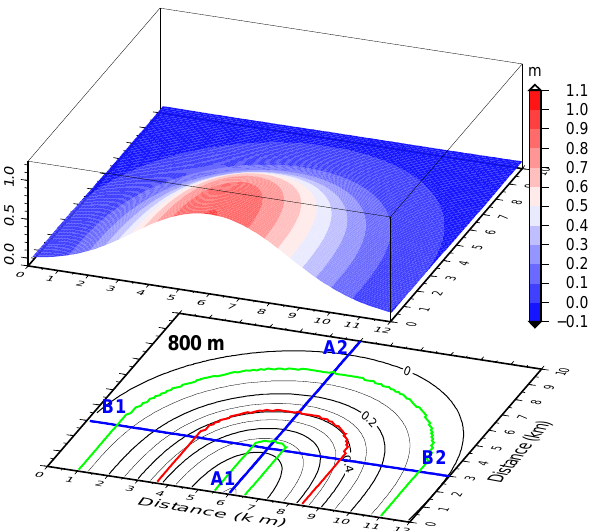
Figure 16. Elastic bulging of an 800m thick ice slab (upper part) in response to a 1m bottom water push exerted over the domain as outlined in red (bottom part). Green contours show the two extreme fjord geometries of the sensitivity test (see Fig. 18) whereas the black ones are the deformation contours corresponding to the 3-D upper view. Also outlined are the two cross sections represented in Fig. 17.